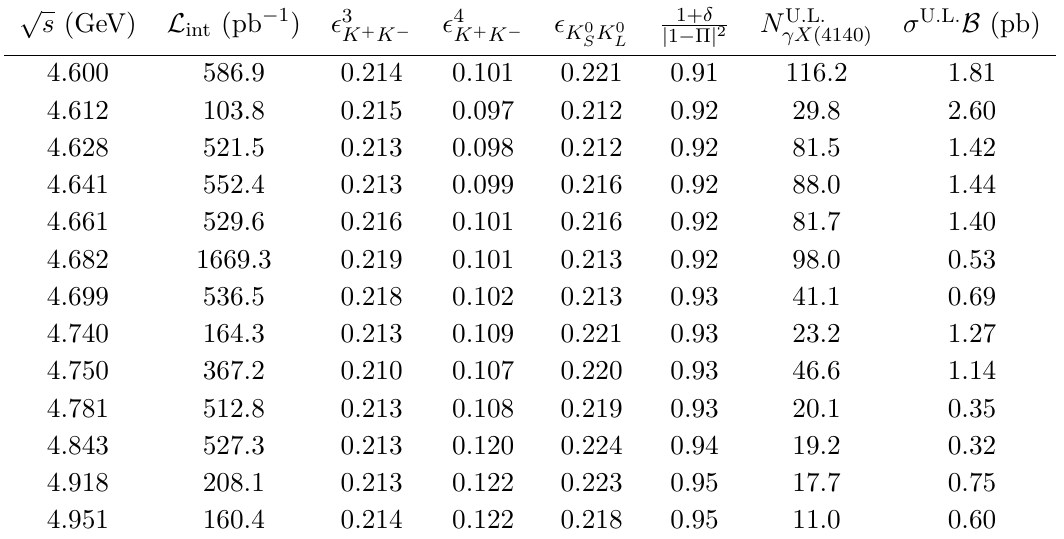
Table 9 . The upper limit of Born cross section at 90% C.L. σ U . L . B ( X → φJ/ψ ) for e + e − → √ γX (4140) at each c.m. energy s . The table also includes integrated luminosity L int , detection